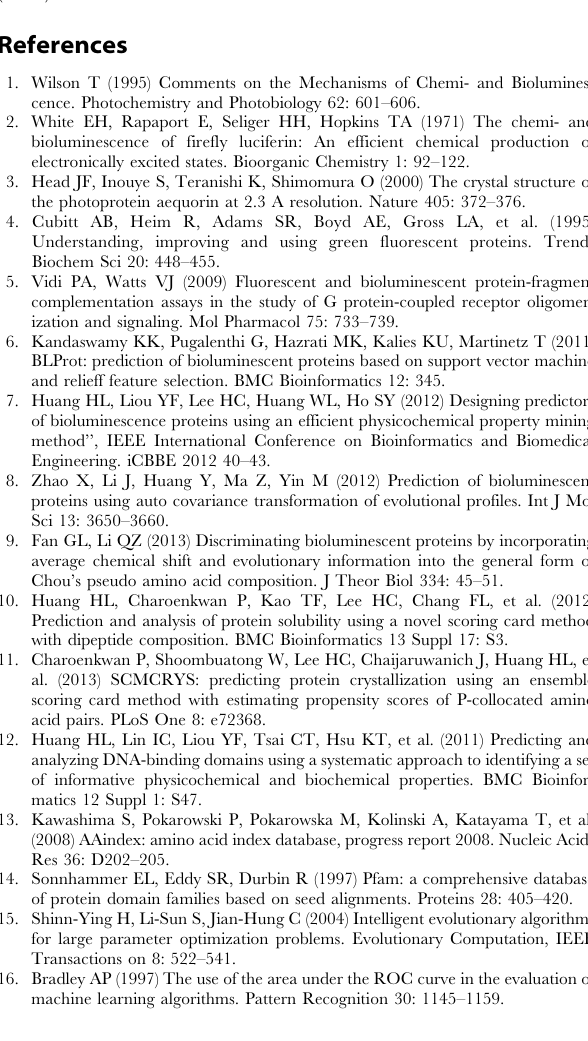
Table S1 The used 39 bioluminescent proteins from Protein Data Bank (PDB). The threshold value to discriminate between BLPs and non-BLPs is 439.627. Table S2 The 94 bioluminescent proteins using the GO Term GO: 0008218 ‘‘bioluminescence’’ annotated on SwissProt. The threshold value to discriminate between BLPs and non-BLPs is